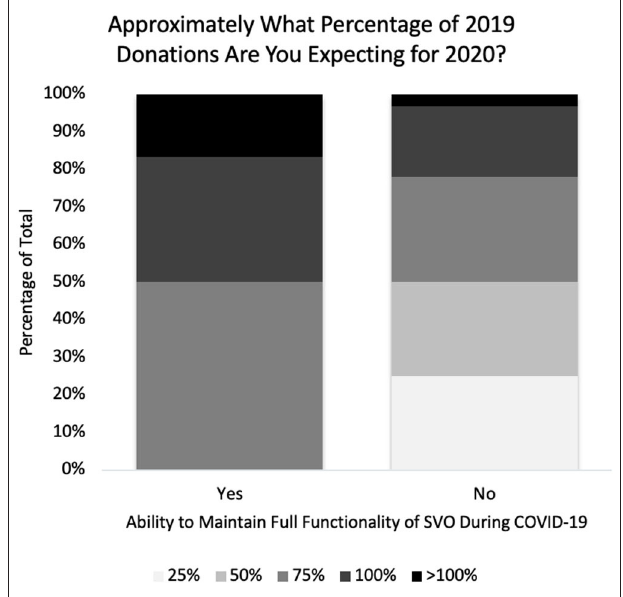
FIGURE 1 | Change in annual donations vs. ability to maintain surgical volunteer organization functionality during the